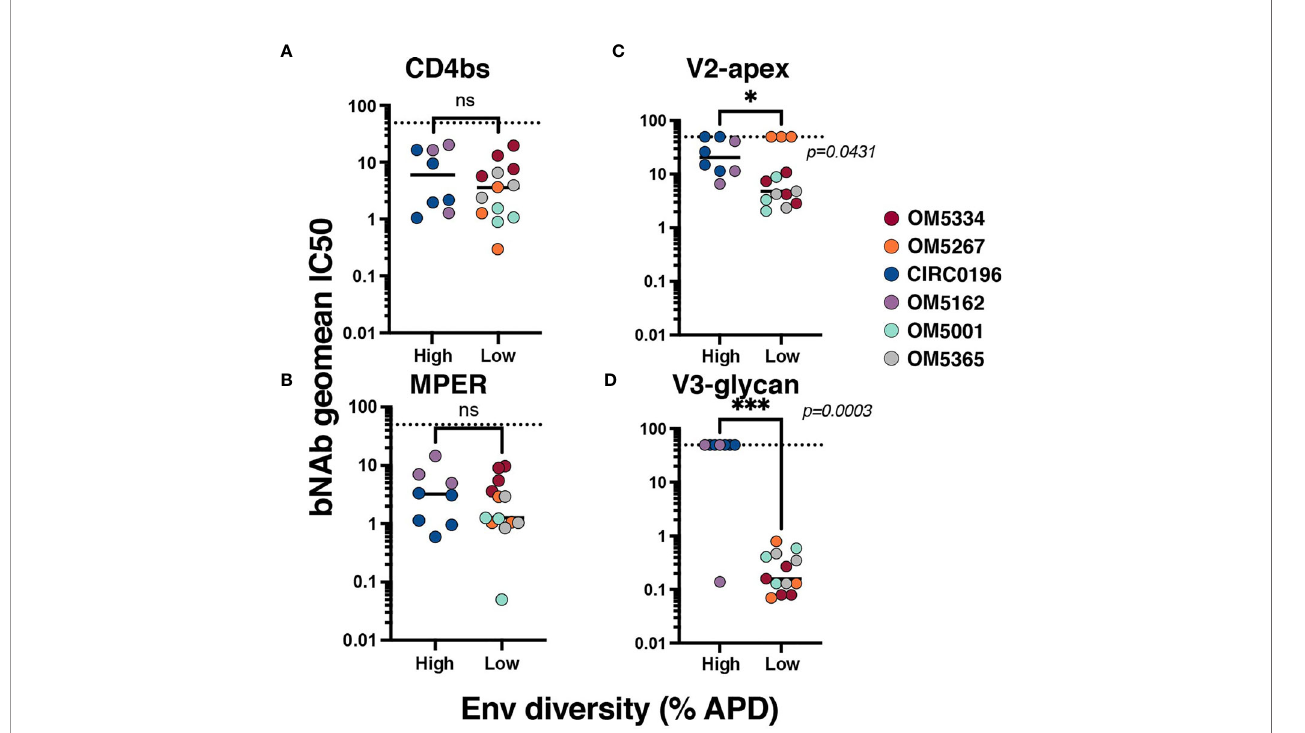
FIGURE 2 | Association between reservoir diversity and bNAb resistance. Each virus was tested for neutralization sensitivity against a panel of 10 HIV-1 bNAbs. The geometric IC 50 of each individuals ’ virus-bNAb pairing was calculated by bNAb epitope: (A) CD4bs antibodies include VRC01, VRC07-523, 3BNC117, and N6, (B) MPER antibody 10E8v4-V5F-100cF (because there is only one bNAb, IC 50 is plotted), (C) V2-apex antibodies PGDM1400, CAP256.VRC26.25, and PG09, and (D) V3-glycan targeting antibodies PGT121 and 10-1074. Geometric mean IC 50 s for each virus are color-coded by individual and grouped by high (>6%APD) or low (<2% APD) Env diversity. Comparisons were performed by Mann-Whitney. * signi fi es p < 0.05. *** signi fi es p < 0.001. ns signi fi es p >